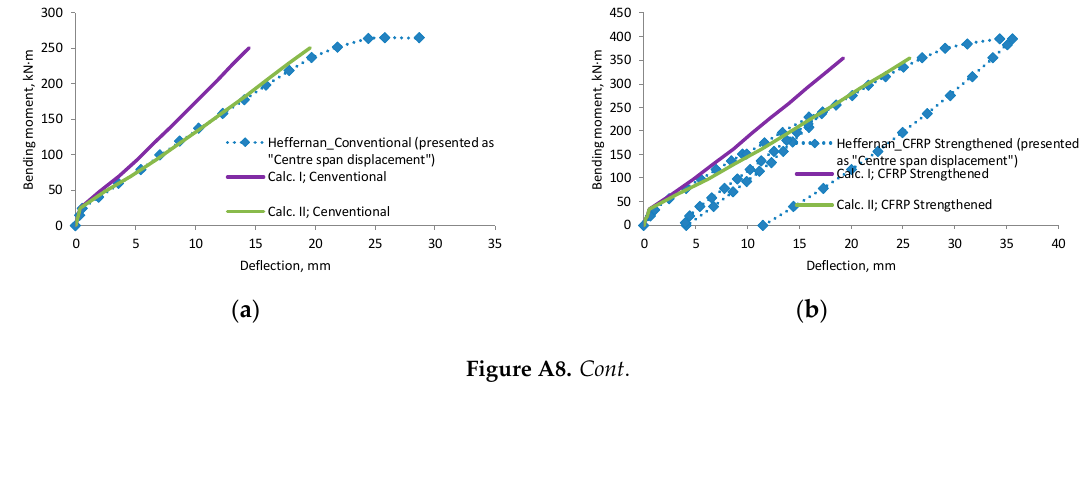
Figure A7. Gao et al., 2006 [30] research beams displacement compared with calculated deflection, ( a ) beam 2O; ( b ) beam 2N4; ( c ) beam 2N6; ( d ) beam 2T450-1; ( e ) beam 2T625-1; ( f ) beam 2T650-1; ( g ) beam 2T675-1; ( h ) beam 2T4100-1; ( i ) scatter of the results at 60 % and 80% of the ultimate load.